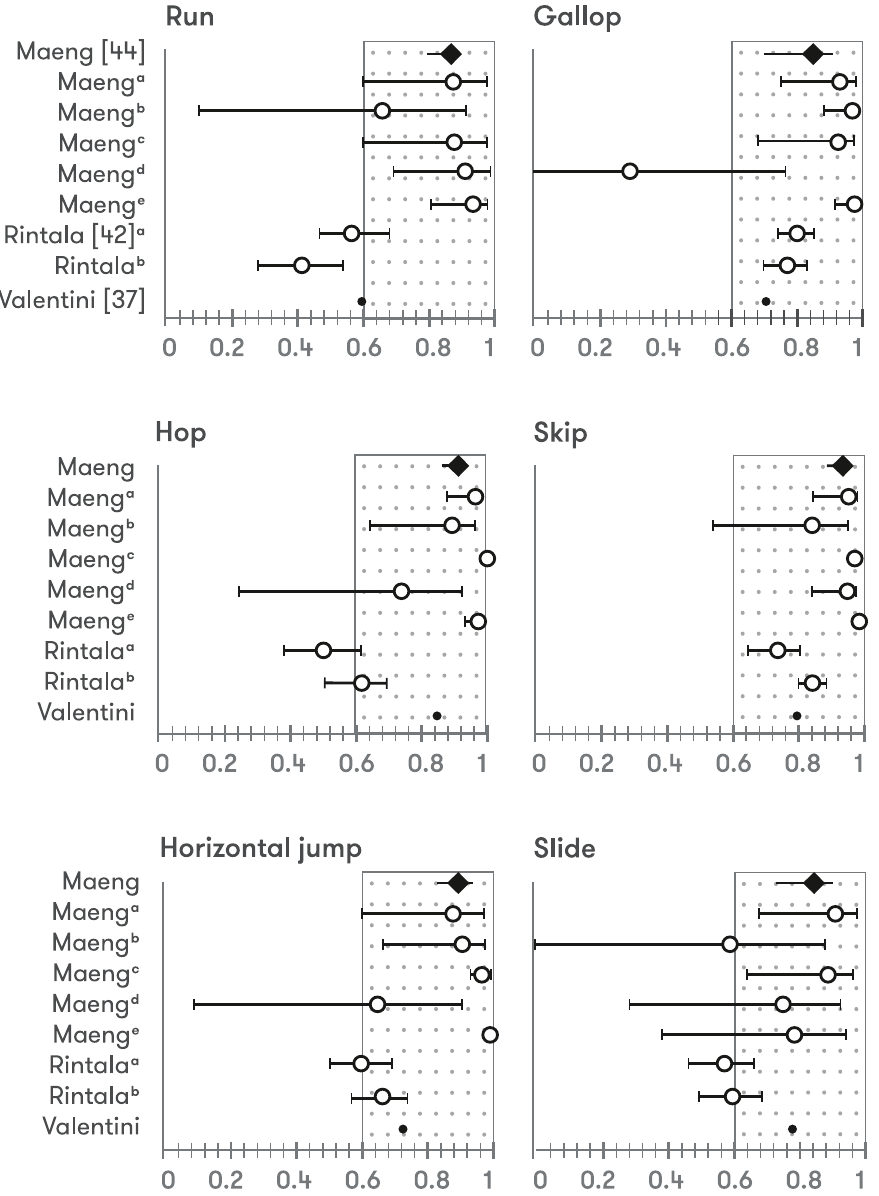
Fig 4. Intra-rater reliability of locomotor skills. a-e : Intra-rater reliability of each rater; Diamonds : Intra-rater reliability of all raters; Open circles : very good quality assessment according COSMIN checklist; Closed circles : adequate quality assessment according COSMIN checklist; Larger circles : ICC & 95%CI; Smaller circles :